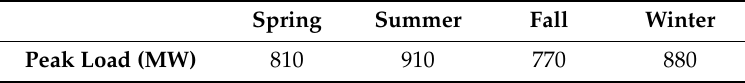
Table 7. Each season’s peak load in Jeju Island [29].